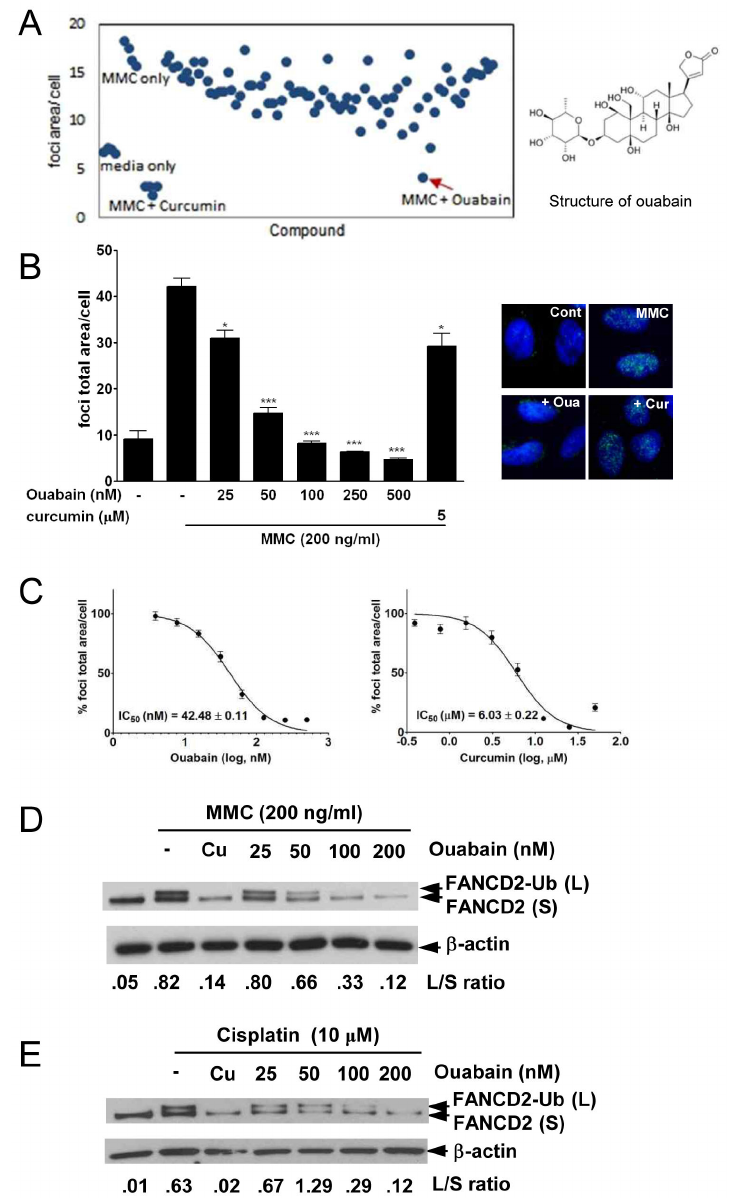
Figure 1. Ouabain inhibits the FA/BRCA pathway. (A) The data from chemical library screening and chemical structure of ouabain. U2OS cells were pre-treated with 5 µM of each compound for 1 h prior to incubation in 200 ng/ml MMC for 24 h. Representative data from plate containing ouabain compound are shown. Each dot in the scattergram represents FANCD2 foci area per cell after treatment with each compound tested. (B) Ouabain inhibits MMC-induced FANCD2 foci formation. U2OS cells were pretreated with the indicated concentration of ouabain or curcumin for 1 h and then treated with 200 ng/ml MMC for 24 h. After incubation, the cells were fixed and processed for FANCD2 immunofluorescence and the FANCD2 foci were analyzed with an IN Cell Analyzer. Representative graphs and images from three independent experiments are shown. Values represent the means ± SEM (Student’s t -test, ***, P < 0.001; *, P < 0.05). (C) U2OS cells treated as described in (B) were analyzed with an IN Cell Analyzer. % foci total area/ cell represents relative % to MMC-only treated samples. IC was calculated using GraphPad Prism 50 version 5.03. Graphs and values represent the means ± SEM from three independent experiments. (D) Ouabain inhibits MMC- induced FANCD2 monoubiquitination. Protein extracts fromU2OS cells treated as described in (B) were analyzed by Western blotting using antibodies against FANCD2 and β-actin. Values shown represent the ratio of FANCD2 (L)/FANCD2 (S). (E) Ouabain inhibits FANCD2 monoubiquitination after cisplatin treatment. Western blotting was performed with protein extracts from U2OS cells treated with 10 µM cisplatin. doi: 10.1371/journal.pone.0075905.g001 PLOS ONE |